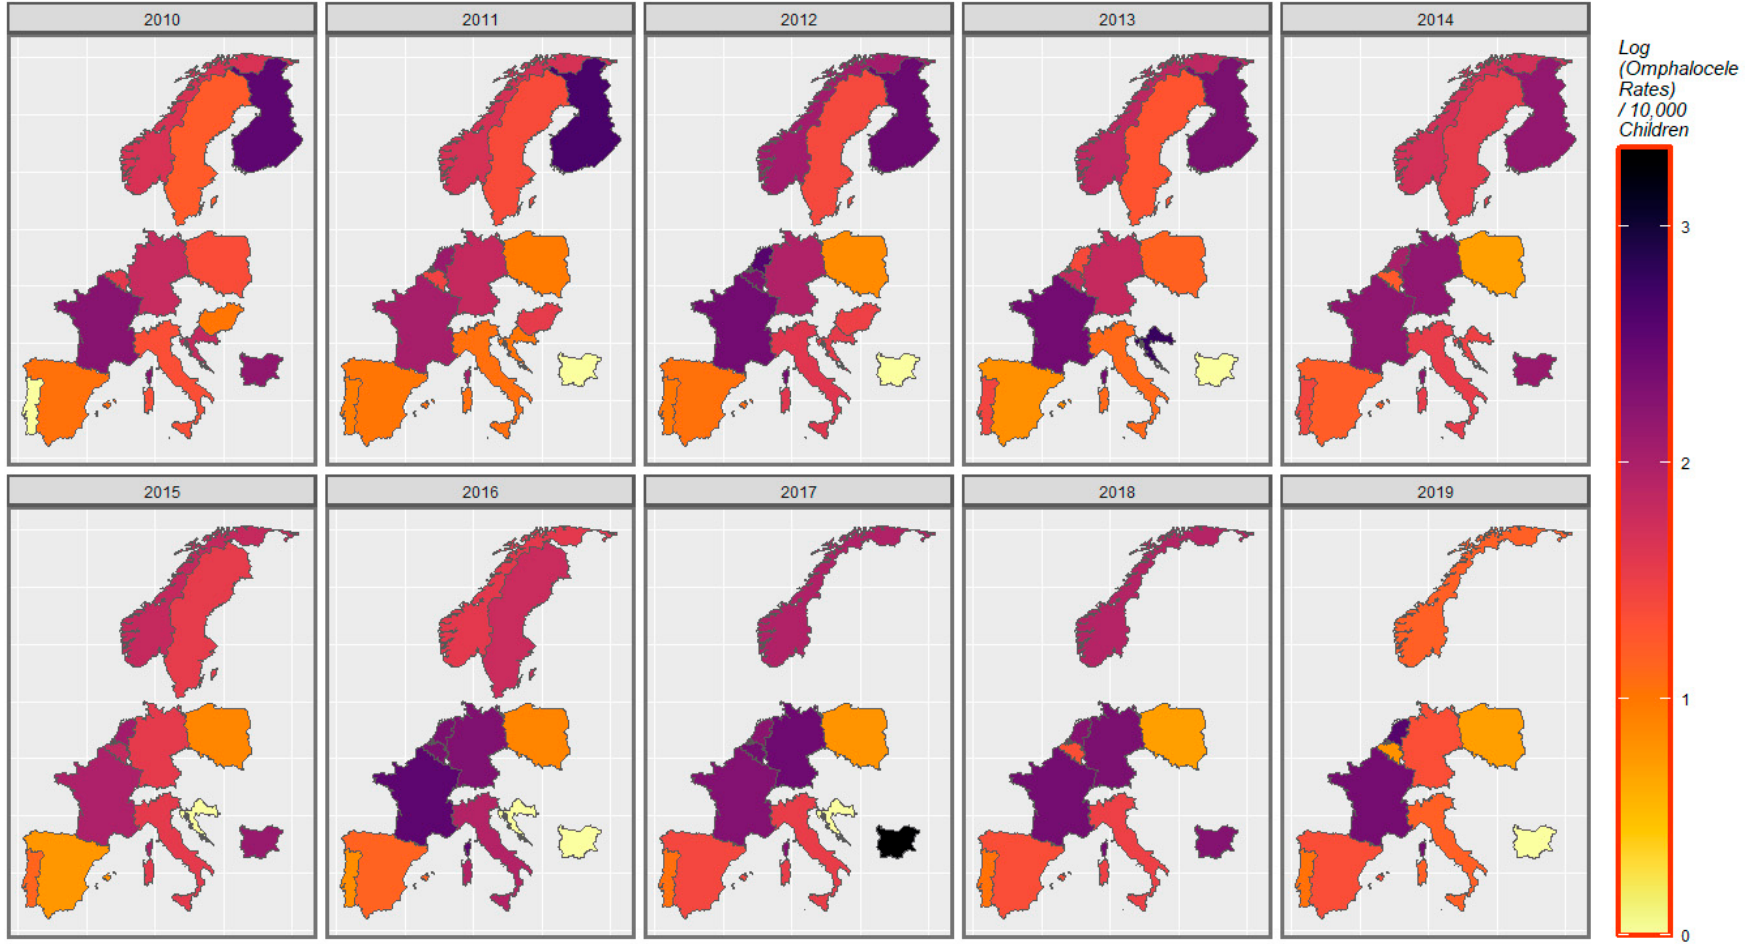
Figure 5. Sequential map-graph of omphalocele across selected European nations for each year of 2010–2019.